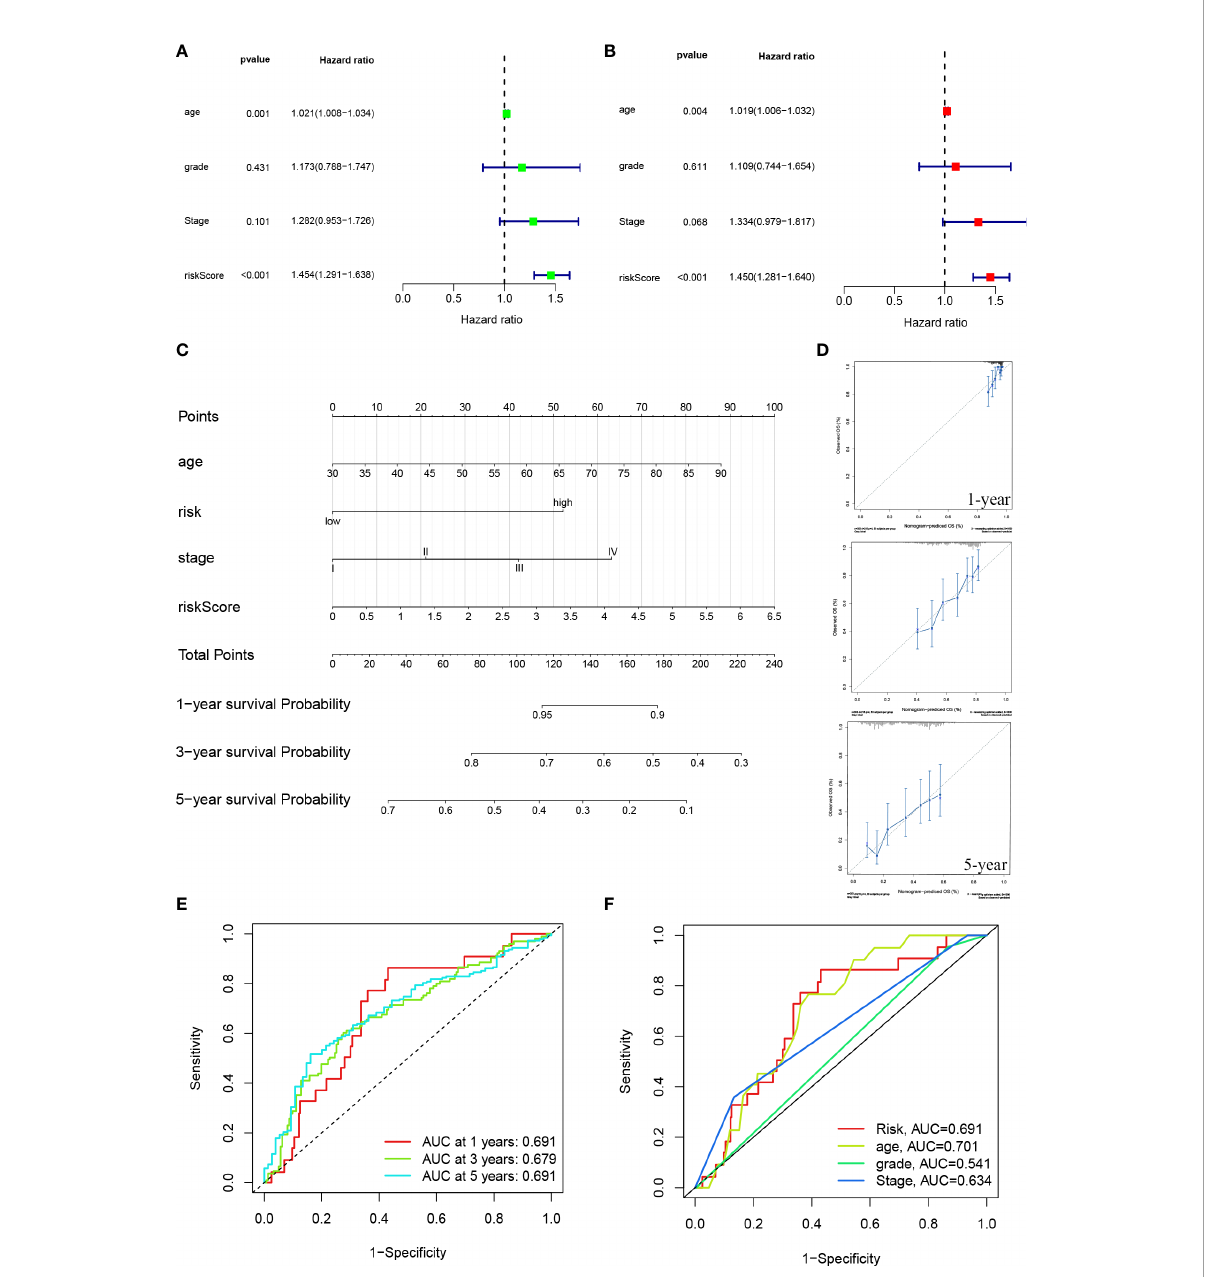
FIGURE 5 ROC diagram and nomogram for the risk model. (A, B) Uni-Cox and multi-Cox analyses of risk score and clinical Characteristics with OS. (C) The probability of the 1-, 3-, and 5-year OS was predicted by combining the nomogram with the risk, risk score, age, and stage. (D) The calibration curves for 1-, 3-, and 5-year OS. (E) The risk model ’ s 1-, 3-, and 5-year ROC curves. (F) Five-year ROC curves of risk score and clinical